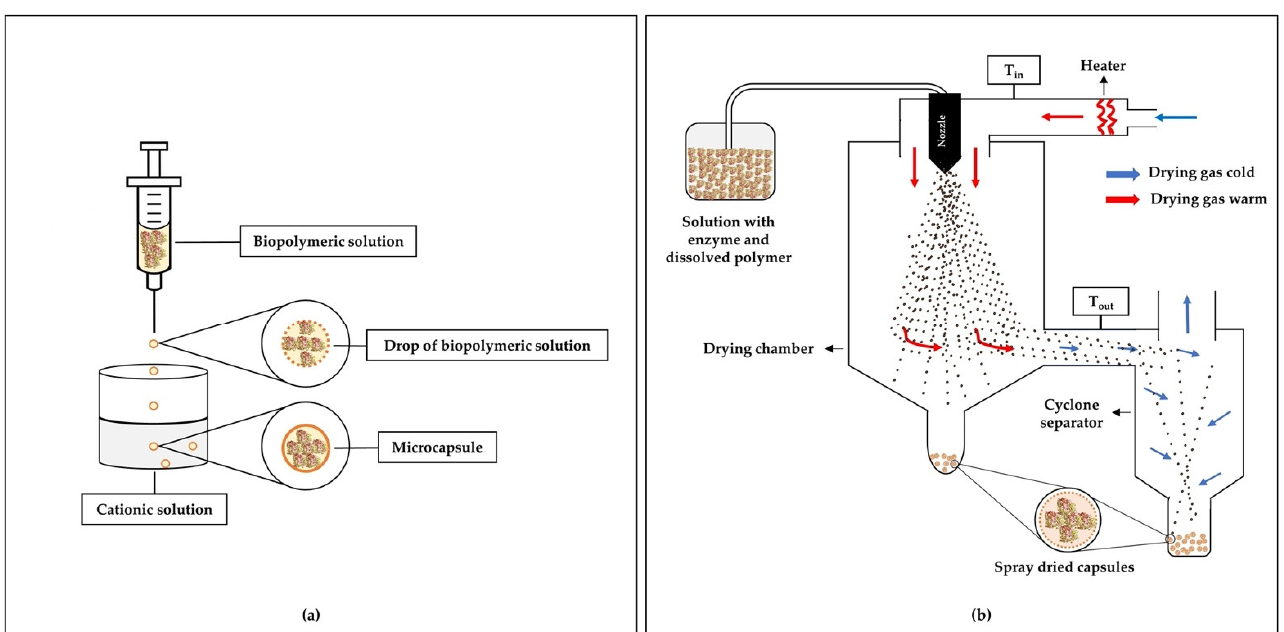
Figure 1. Schemes for encapsulation of enzymes using polymers: ( a ) ionic gelation method and ( b ) spray drying method.